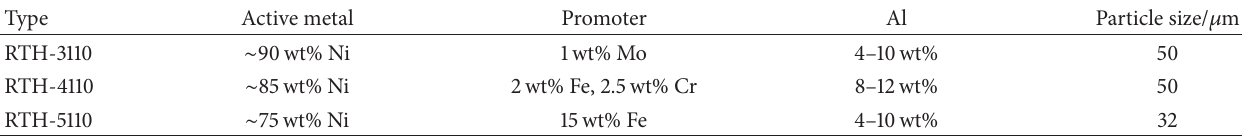
Table 2: Metal element analysis of Raney nickel